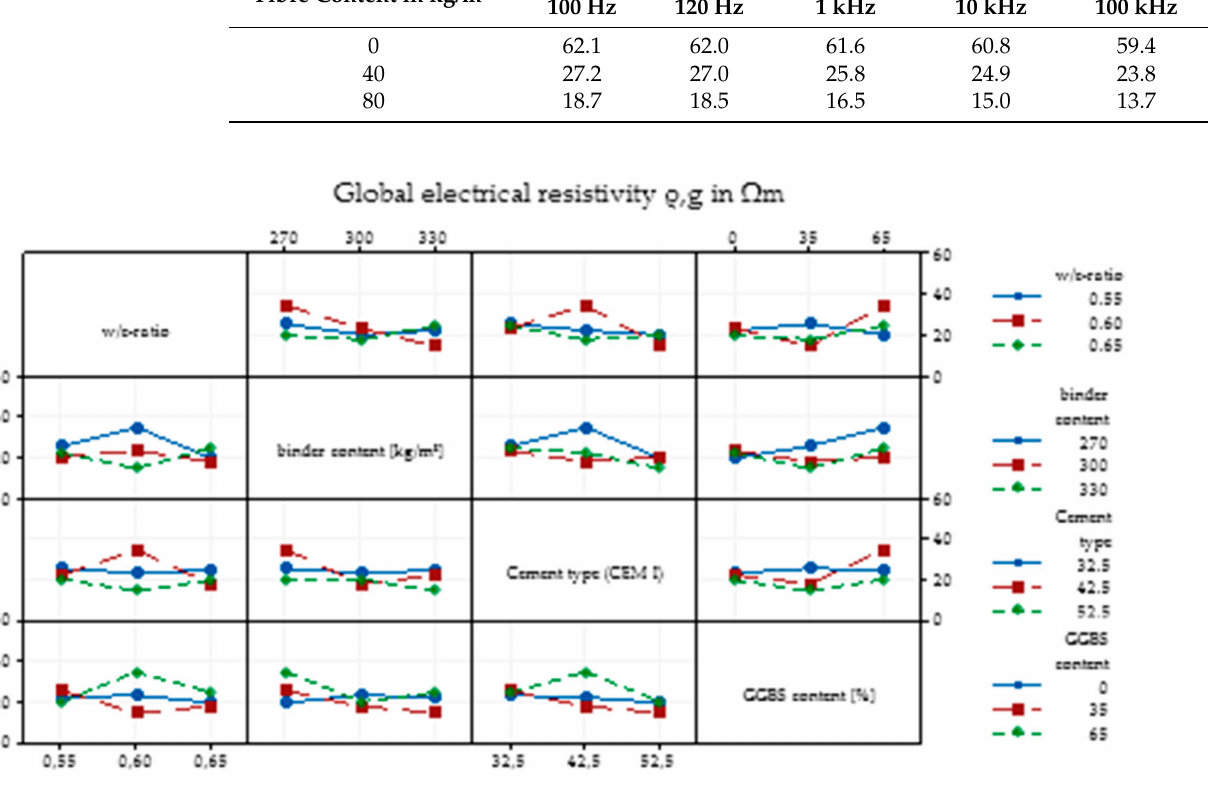
Figure A1. Interaction plot of the effects of the concrete composition on the global electrical resistivity of SFRC calculated by Minitab based on the mixtures of the multiple parameter